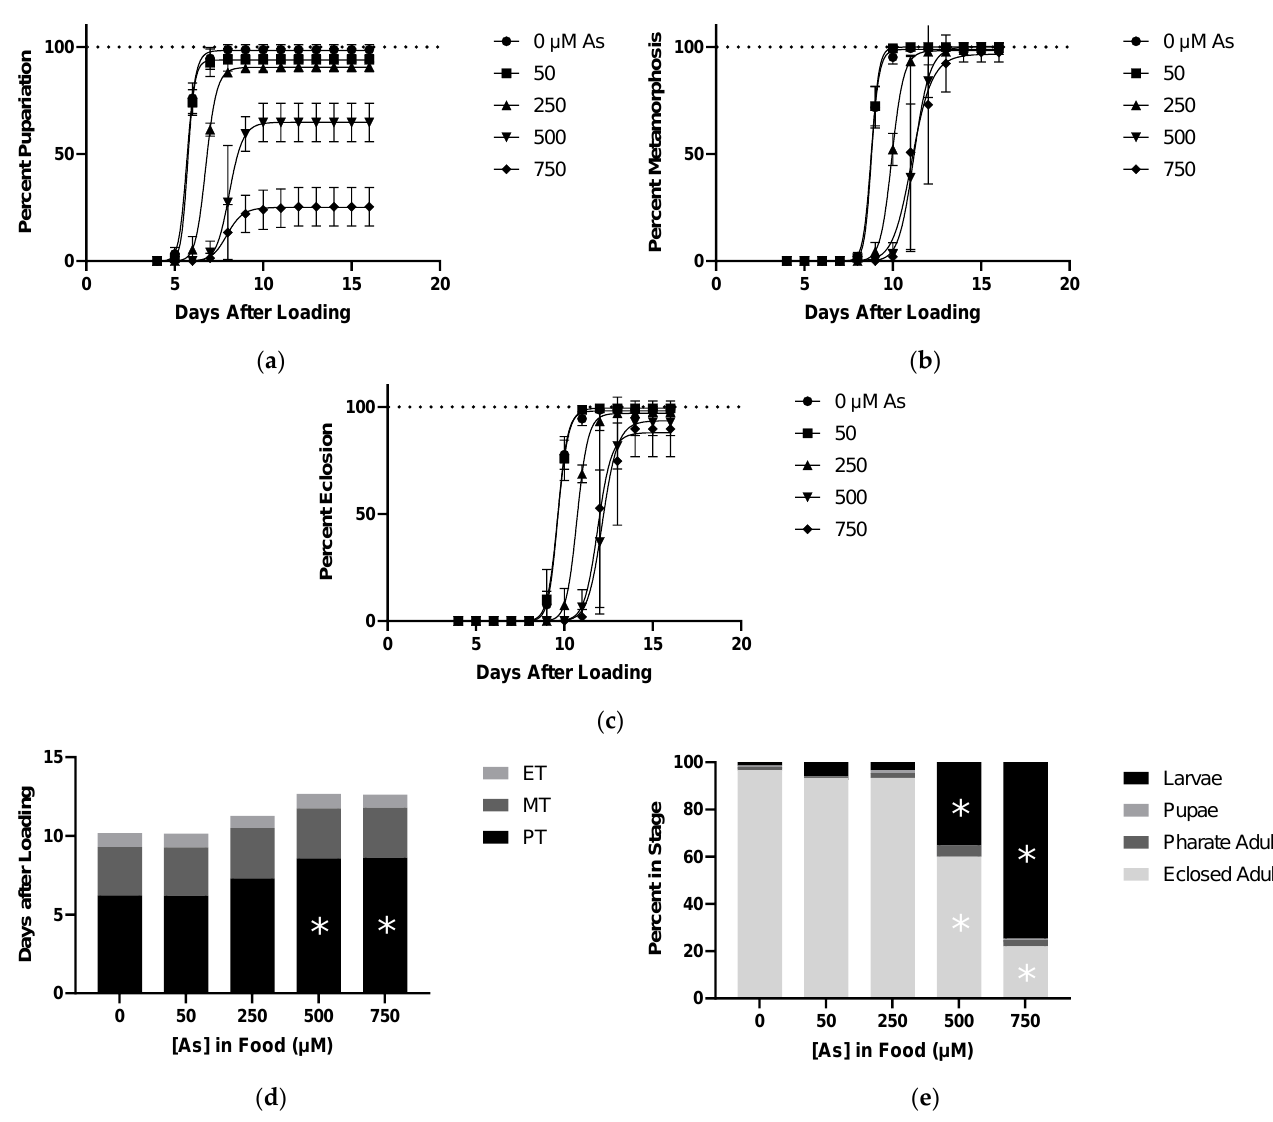
Figure 3. Effects of As on Developmental Time Course. All data from same experiment using CS larvae dosed with indicated concentrations of As in food. ( a ) Pupariation: pupae formation rates of larvae after being loaded onto food. ( b ) Pupa Metamorphosis: pharate adult formation rates of pupae standardized to total pupae formed. ( c ) Pharate Adult Eclosion: rate of eclosion standardized to total number of individuals completing metamorphosis. ( d ) Developmental Timing: representation of time spent in each stage derived from data shown in Figure 1a – c. This allows for accounting of delays seen in later stages caused by carryover of pupariation delays. ( e ) Developmental Endpoints: representation of individuals in each stage at the defined endpoint of 16 days from 1a – c. Individuals that are not eclosed adults correspond to a lethality during development. (* p < 0.05 compared to 0 µM, two-way ANOVA).